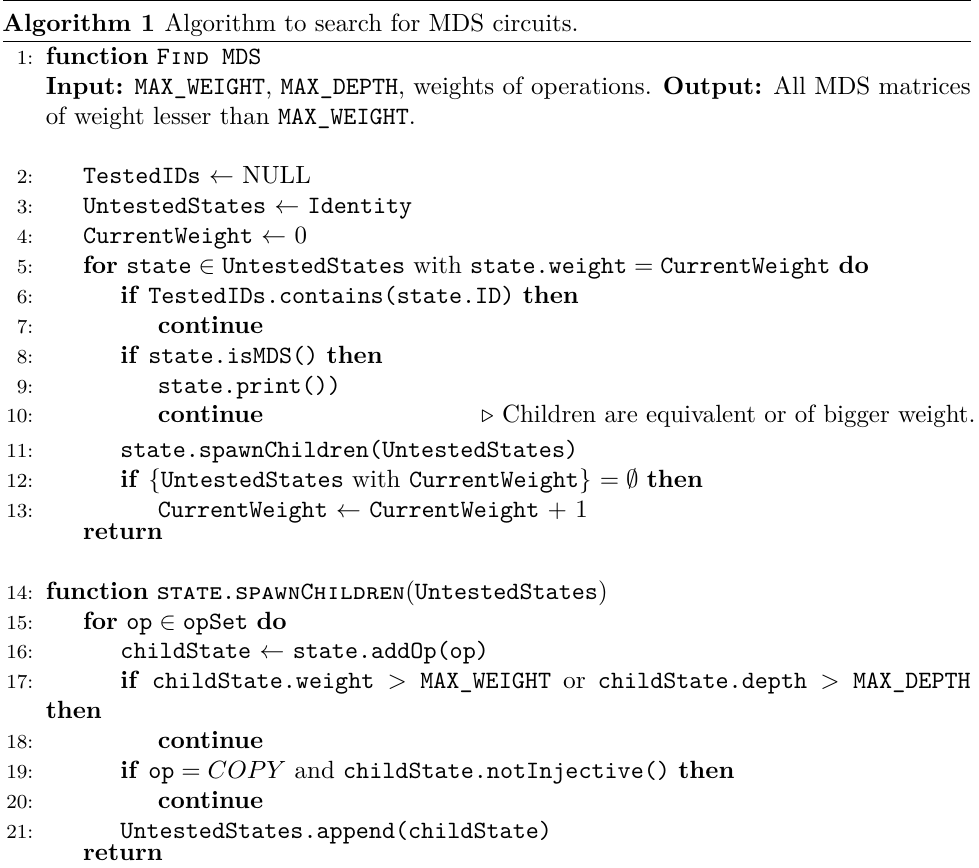
Algorithm 1 Algorithm to search for MDS